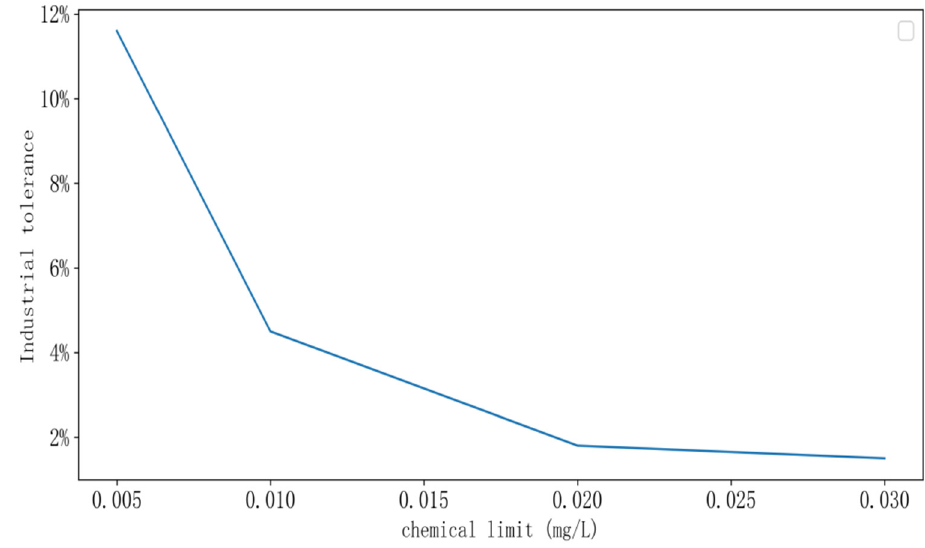
Figure 7. Industrial tolerance.